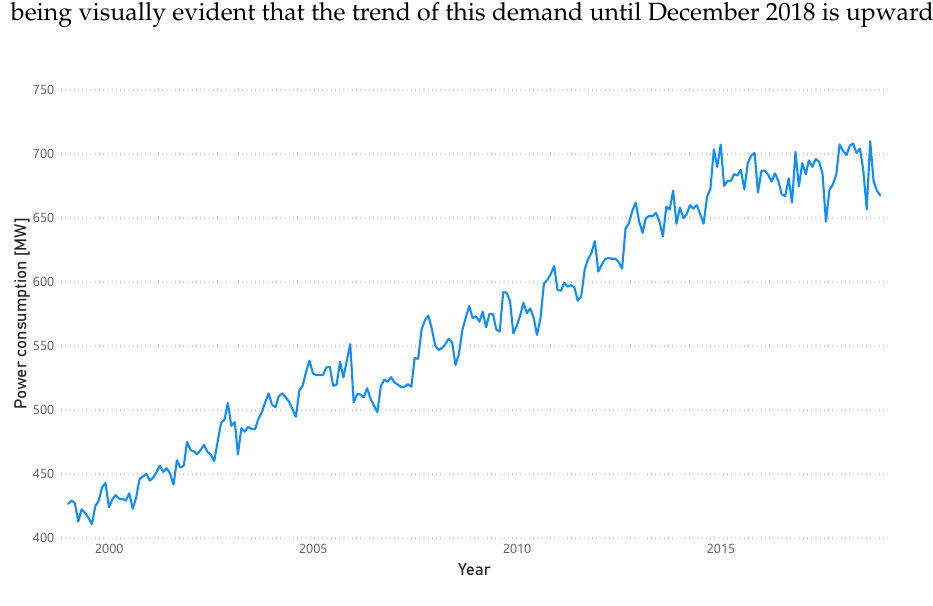
Figure 1. Monthly power consumption in Quito, Ecuador between January 1999 and December 2018. On the other hand, Figure 2 shows the electricity demand from 2013 to 2020, consider- ing the atypical years 2019 and 2020, in this figure, it can be seen that the trend in electricity demand until 2018 is upward (black dotted line), however this is not true for data from 2018 onwards (red dotted line).